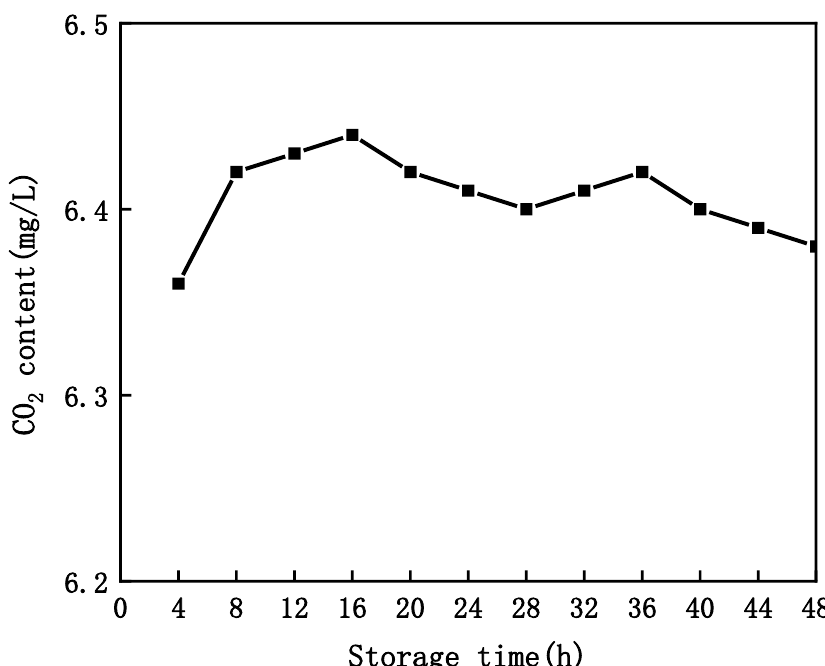
Figure 10. Variation trend of the CO 2 content in the MNB water.